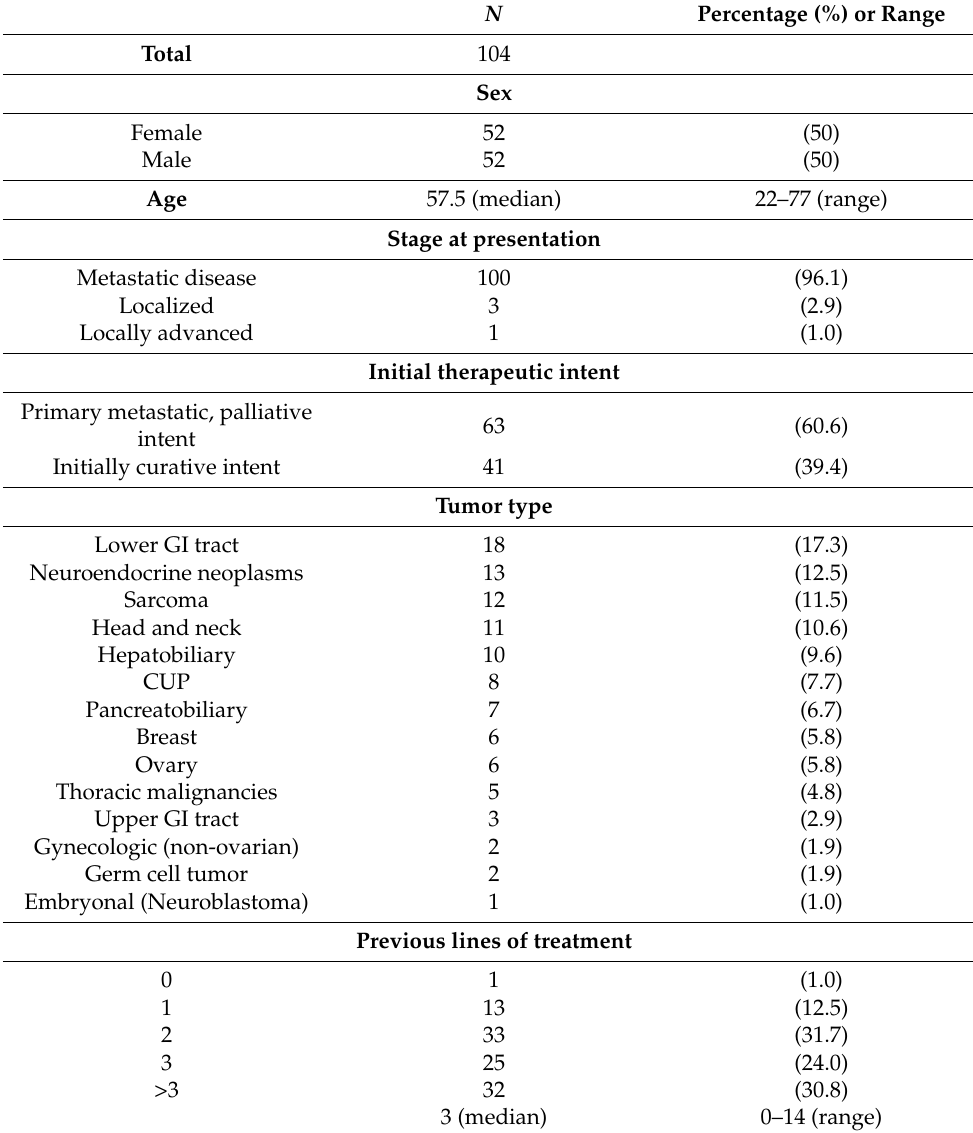
Table 1. Patient characteristics of 104 patients whose tumors were subjected to molecular testing for precision